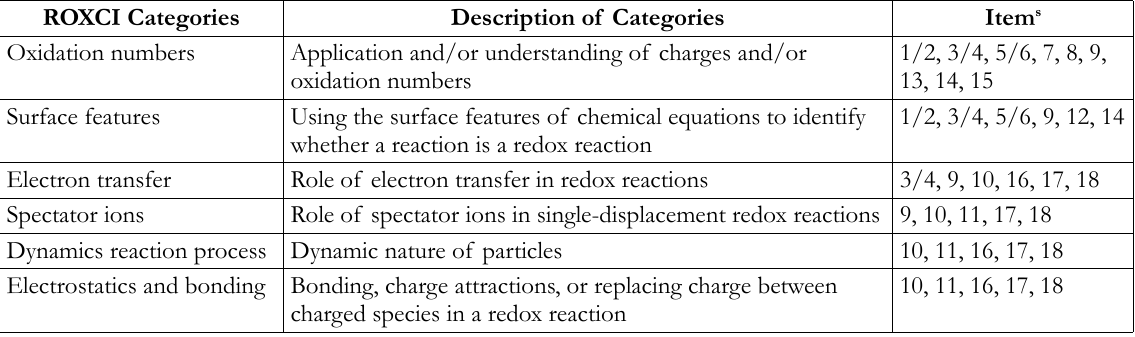
Table 2. Major Misconceptions Categories Assessed by The